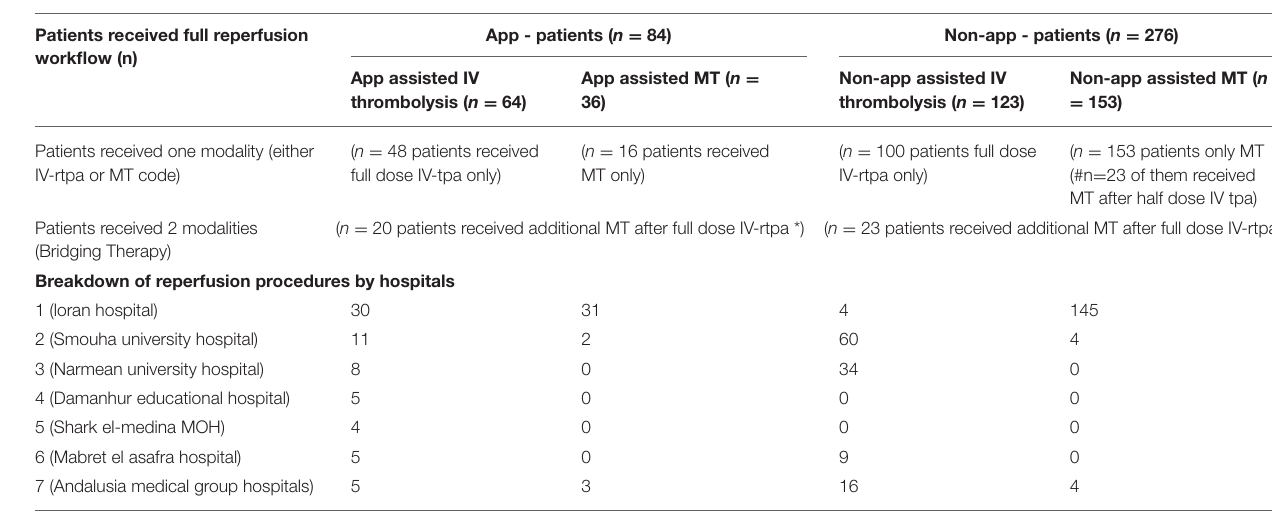
TABLE 1 | Patient data uploaded by participating hospitals.